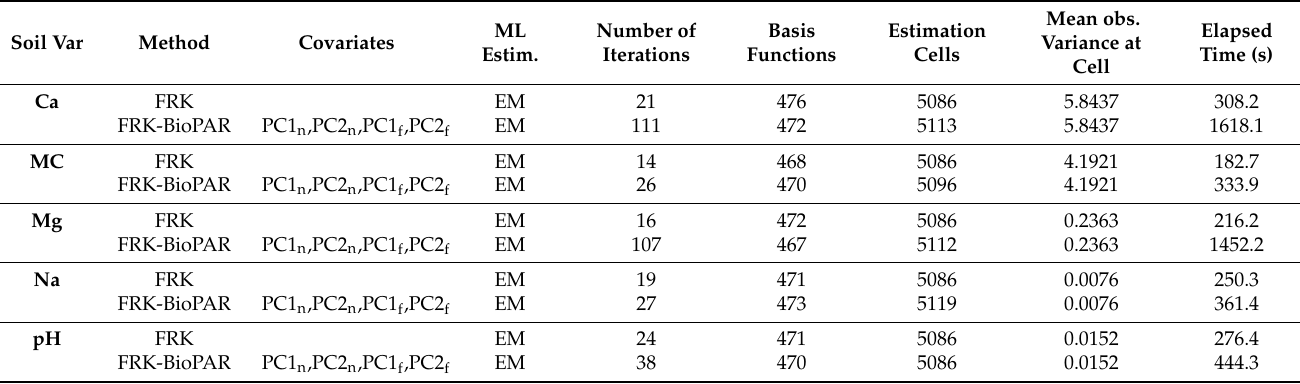
Table 7. FRK interpolations summary of spatial random effects (SRE) model’s summary for FRK and FRK-BioPAR.